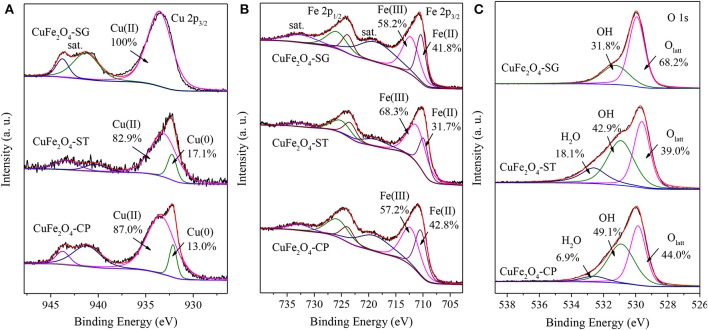
XPS spectra of CuFe2O4 synthesized by different methods: (A) Cu 2p, (B) Fe 2p, and (C) O 1s.